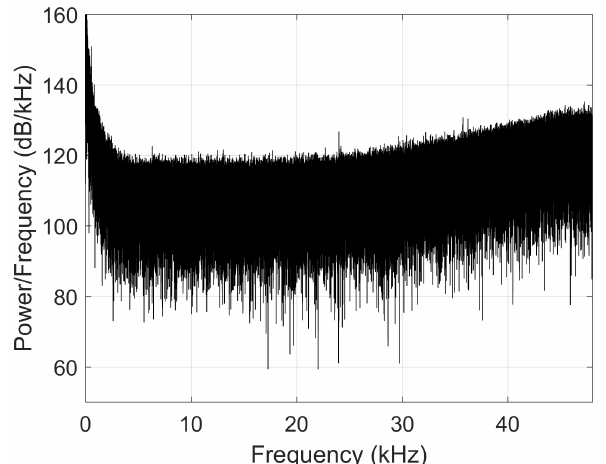
Figure 6. Power spectral density estimated using Welch’s method from 5s of data containing only background noise, showing the in- crease of power for frequencies above